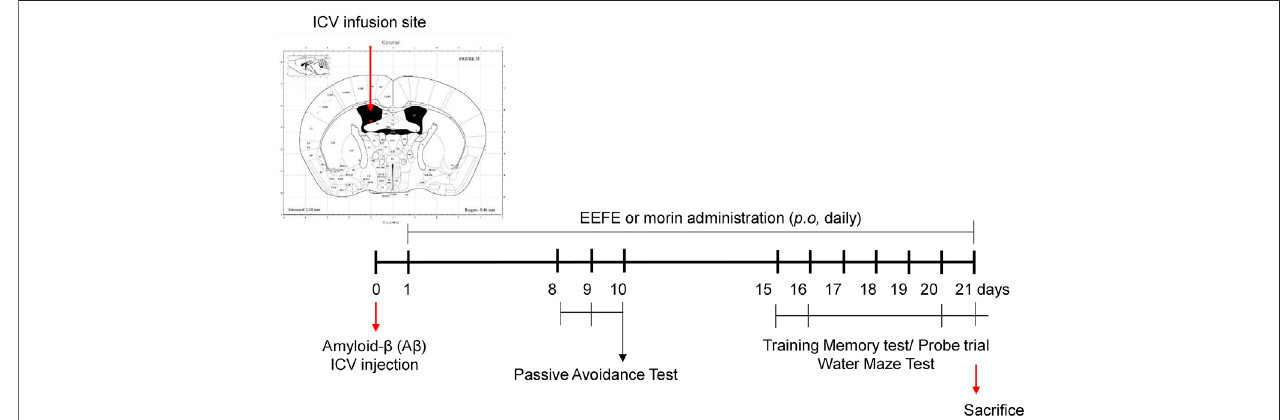
FIGURE1| TimelineforEEFEadministrationandbehavioraltestsintheanimalexperiments.Amyloid- β aggregateswereinjectedatintracerebroventricular(ICV)areawith stereotaxicapparatusintomaleC57BL6mice.EEFE(50or100 mg/kg)ormorin(10 mg/kg)wereorallytreateddailyfor20 days.Thepassiveavoidancetaskwasperformedon the 8 th – 10 th day. Morris water maze test (MWM) was conducted on the 15 th – 21 st day. EEFE: ethanol extracts of Ficus erecta . Image of the ICV infusion site was made from Mouse Brain Atlas (labs.gaidi.ca). Atlas Source: Paxinos, George, and Keith B. J. Franklin. The mouse brain in stereotaxic coordinates: hard cover edition.